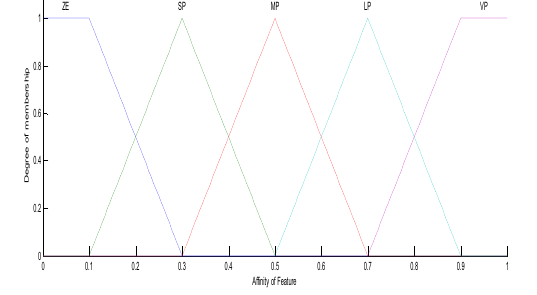
Algorithm: Online multi-target tracking based on fuzzy Logic Data Association(PROPOSED ALGORITHM)